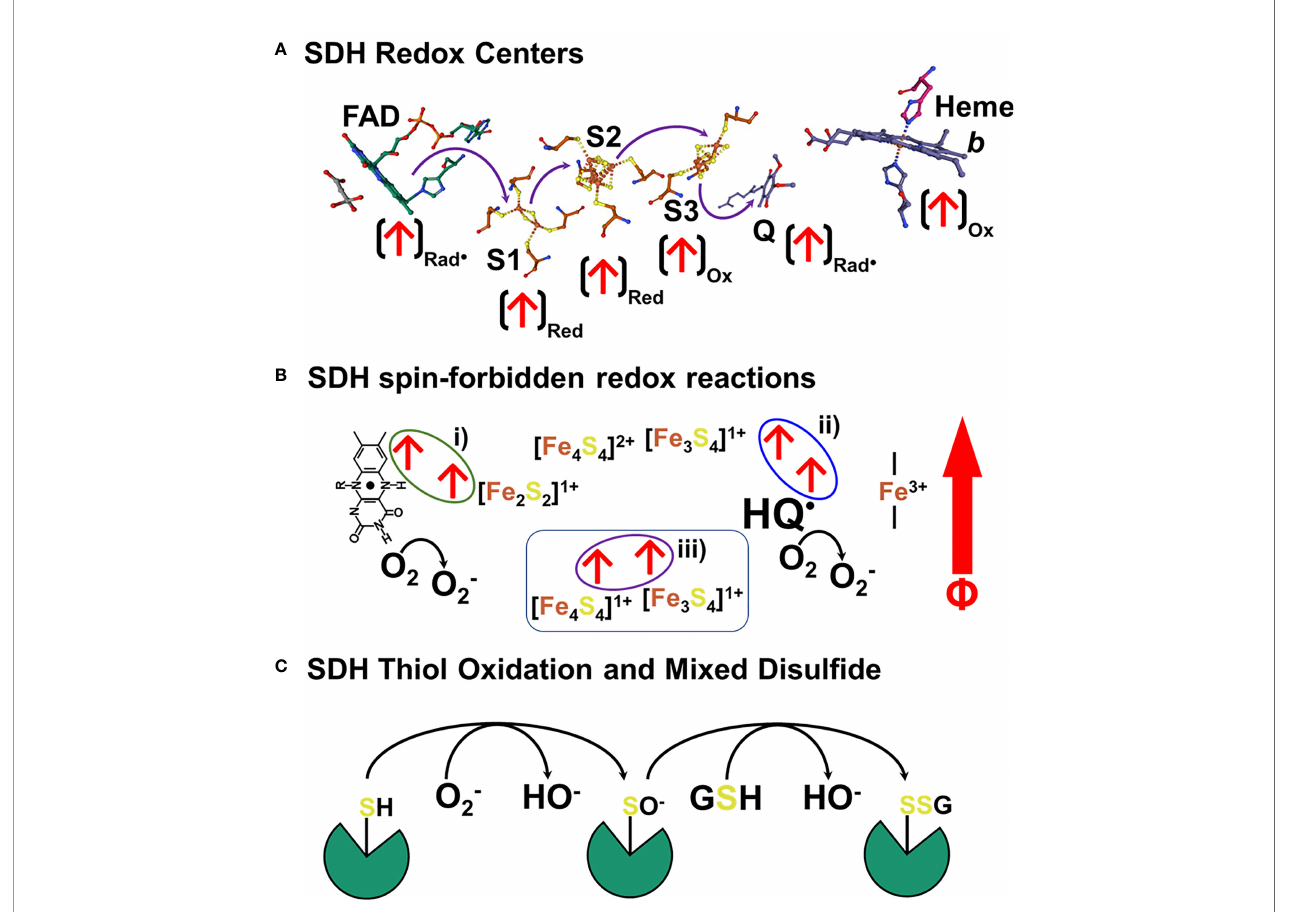
FIGURE 10 | Schematic representation of a hypothetical mechanism of SDH inhibition and ROS generation in response to sOMF. (A) shows the arrangement of redox centers in SDH, from the substrate binding site (left) occupied by oxaloacetate to the heme b (right), based on the 1YQ3 crystal structure. An arrow at each redox center, ( ↑ ), identi fi es the redox state when the center is a radical (ox, red or rad (cid:129) ). There are three different biradical pairs that may be subject to coupling to an external magnetic fi eld. Firstly, the fl avin radical and the S1 [Fe 2 S 2 ] 1+ center, 10B i). Secondly the biradical-redox pairing of S2 [Fe 4 S 4 ] 1+ and the S3 [Fe 3 S 4 ] 1+ center, (B ii) . Finally, the S3 [Fe 3 S 4 ] 1+ semiquinone radical (HQ (cid:129) ) radical pair, (B i) . Trapped fl avin and quinone radicals, could reduce paramagnetic oxygen to superoxide. In (C) we present a simple scheme that shows how SDH is inactivated by sOMF, based on SDH thiol sensing, with sOMF treatment causing SDH to